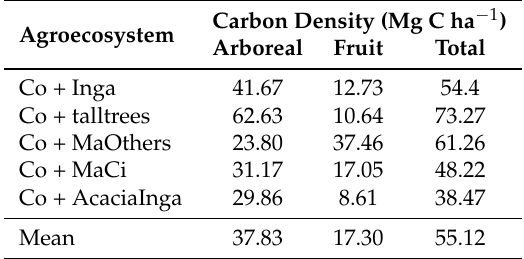
Table 6. Density of aboveground C (Mg C ha − 1 ) by type of coffee agroecosystem in the study region Veracruz,